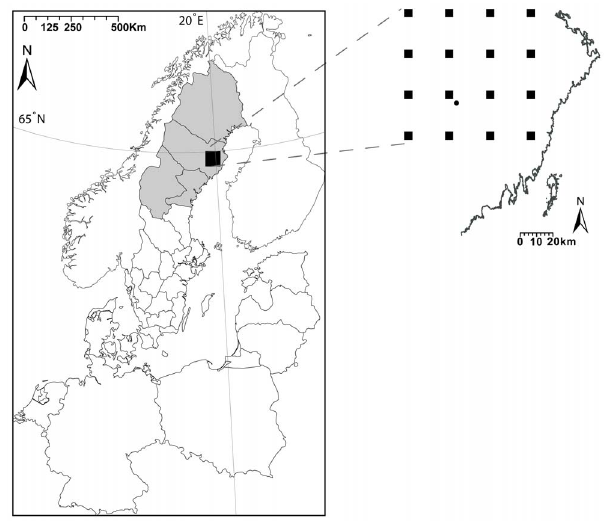
Figure 1. Map of the study area. The black square represents the 100 6 100 km rodent monitoring area. The grey area constitutes the four northernmost counties in Sweden, representing 55% of the total area of Sweden, and used to calculate and predict incidence. The blow- up shows the trapping design and the location of Svartberget climate station (black circle), from which temperature and precipitation data to classify rainy winter days were retrieved.